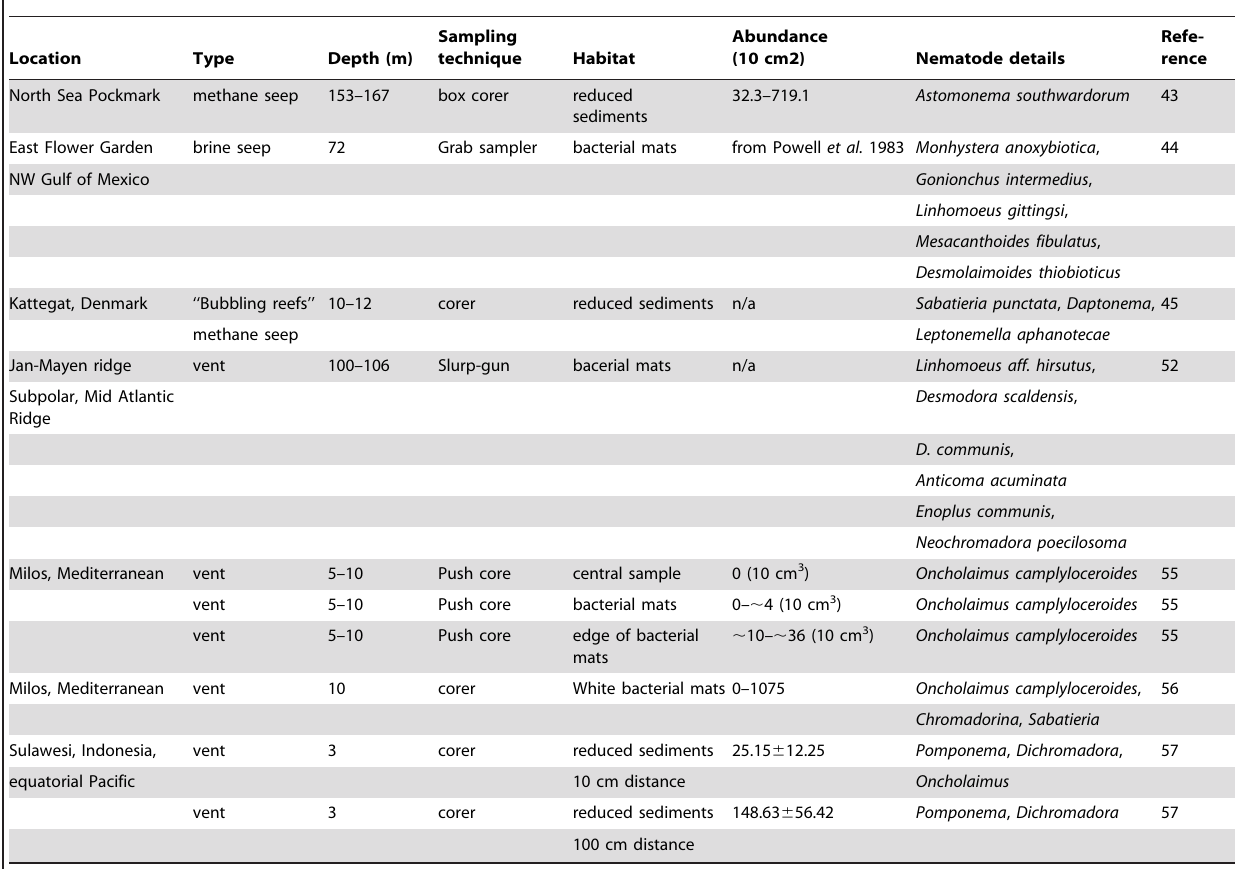
Table 4. Shallow seeps and hydrothermal